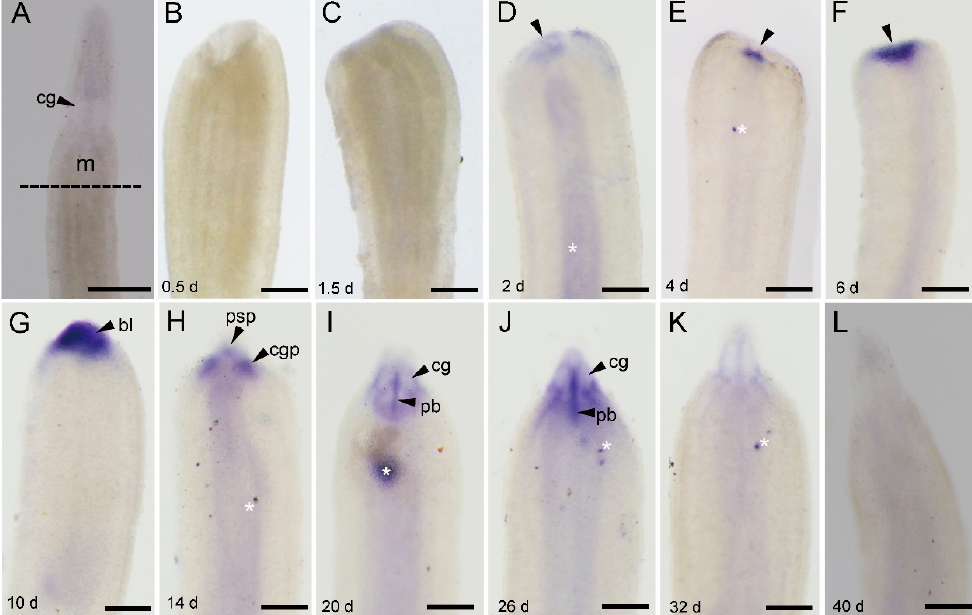
Figure 3. Ls-piwi1 expression during the anterior regeneration of Lineus sanguineus . ( A ) Anterior region of an adult worm (control). The dashed line indicates the site to perform amputation. ( B , C ) Images from 0.5 and 1.5 days post amputation (dpa), respectively, no positive staining. ( D ) Image from 2 dpa, with complete wound healing and slight expression (arrowed). ( E – G ) Images from 4, 6, and 10 dpa, respectively, showing expression in the blastema (arrowed). ( H ) Image from 14 dpa, showing expression in three parts, an anterio-middle part and two posterio-lateral parts. ( I , J ) Images from 20 and 26 dpa, respectively, with expression in the proboscis and around cerebral ganglia. ( K ) Image from 32 dpa, with weak expression around cerebral ganglia. ( L ) Image from 40 dpa, no positive expression. Abbreviations: cg, cerebral ganglia; cgp, cerebral ganglion primordium; m, mouth; pb, proboscis; psp, proboscis and proboscis sheath primordium. Asterisks mark nonspecific staining (unexpected spots on body surface and diffuse staining in intestine; see Figure S4, Supplementary Materials). Scale bars: A = 500 μ m; B–L = 200 μ m.